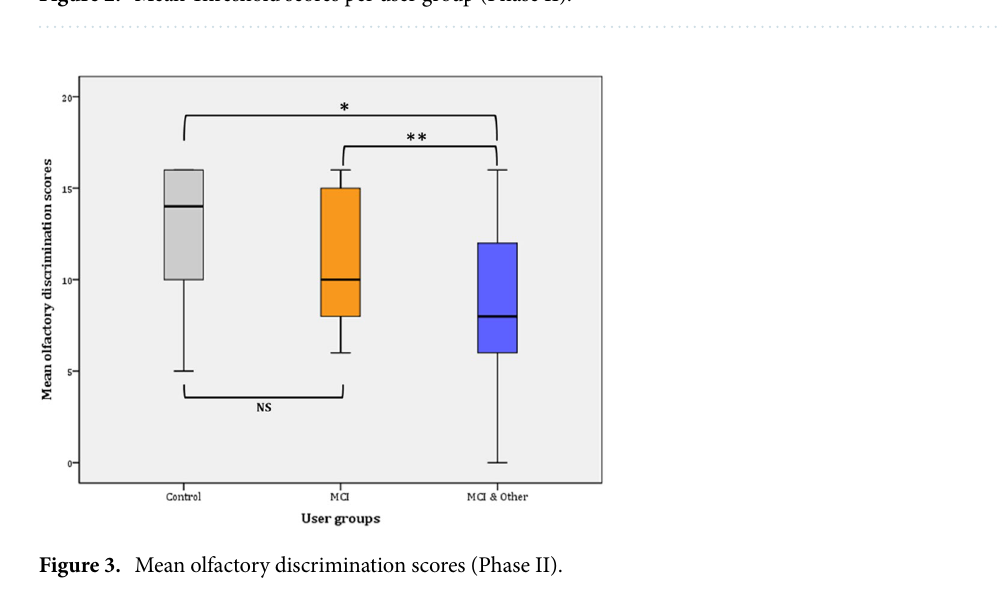
Figure 2. Mean Threshold scores per user group (Phase II).